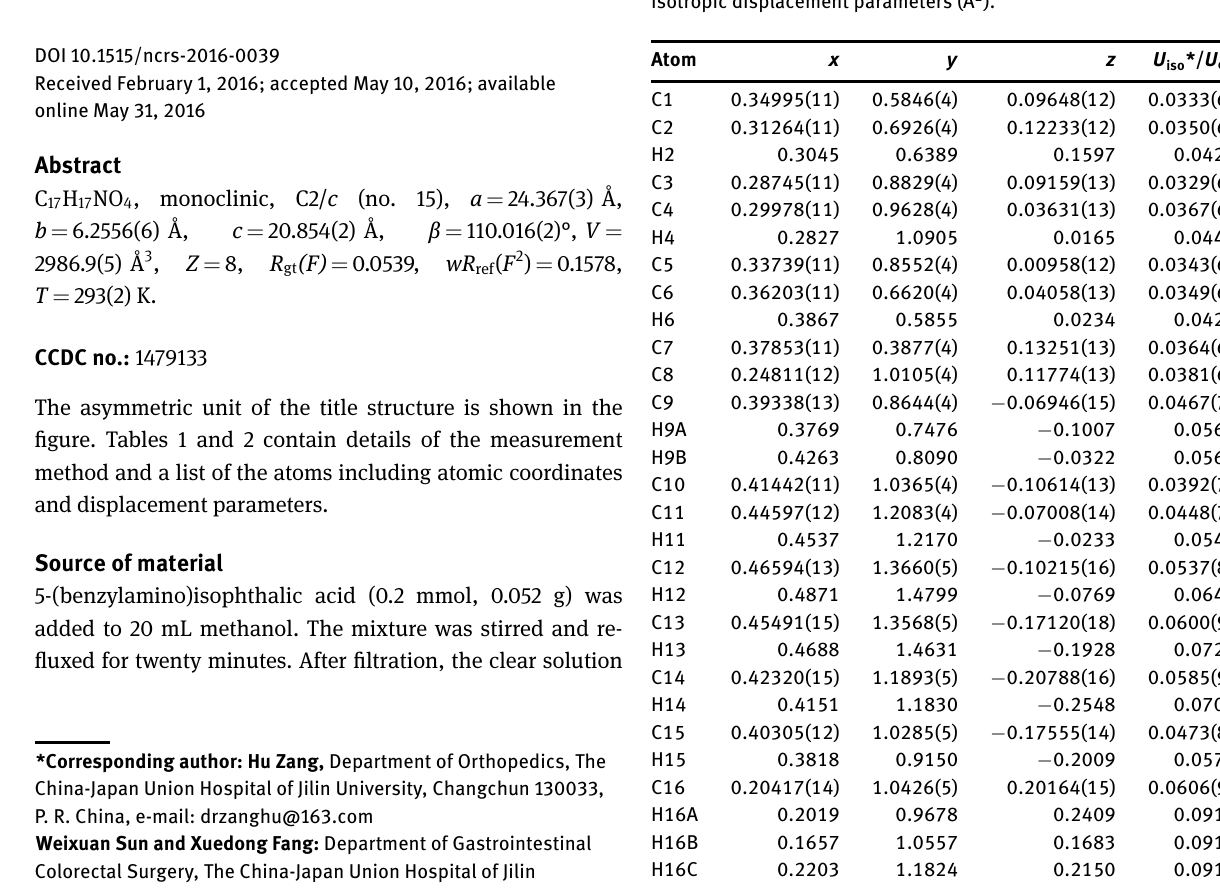
Table 2: Fractional atomic coordinates and isotropic or equivalent isotropic displacement parameters (Å 2